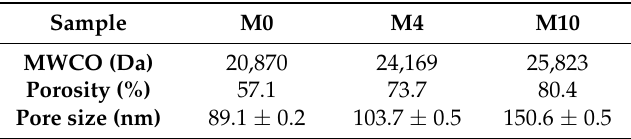
Figure 15. Polyethylene glycol (PEG) retention rate as a function of molecular weight for Membranes: M0, M4, and M10. Table 5. Molecular weight cut-off (MWCO), porosity and pore size of the membranes: M0, M4, and M10.